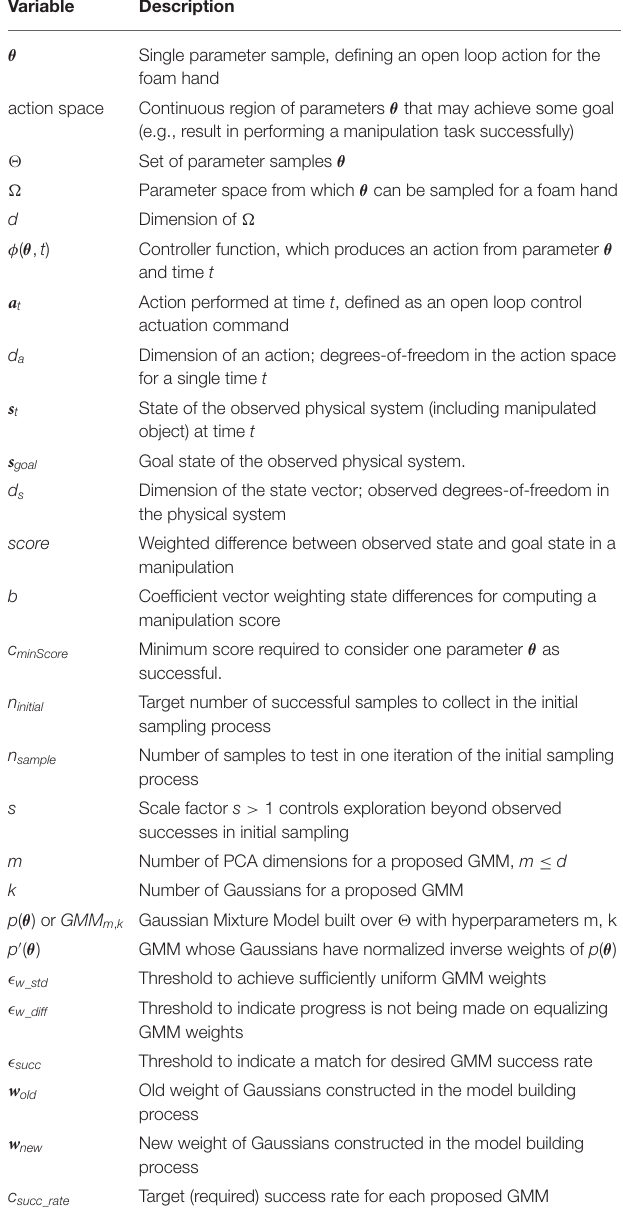
TABLE 1 | Variable Table. Variable